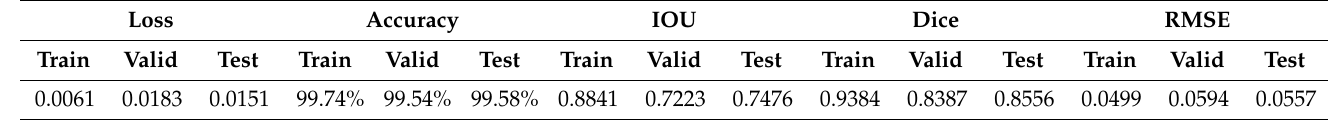
Table 6. Result of transfer-training using the proposed